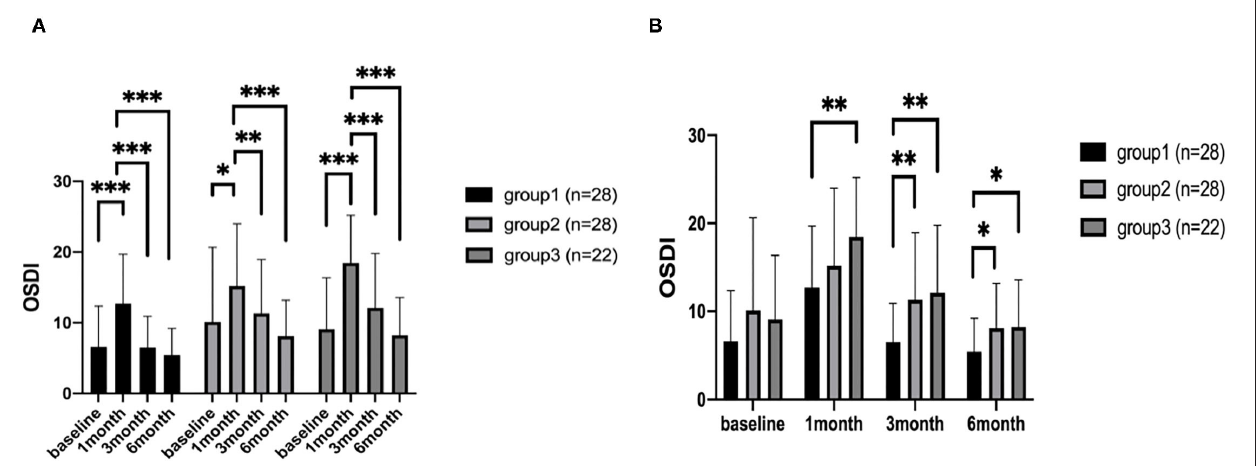
FIGURE 1 | The OSDI scores of patients. The comparison of different time points measured preoperatively, at 1, 3, and 6 months after corneal refractive surgery (A) . The comparison among the three groups (B) . * P < 0.05, ** P < 0.01, and *** P < 0.001 (OSDI, eye surface disease index questionnaire).